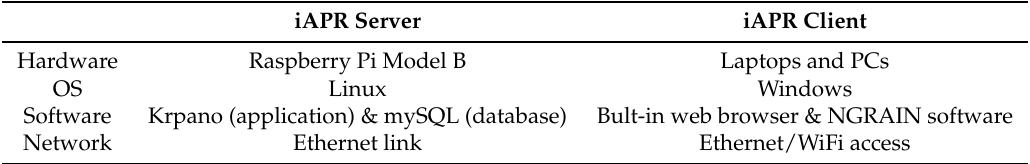
Table 1. System prototype configuration.